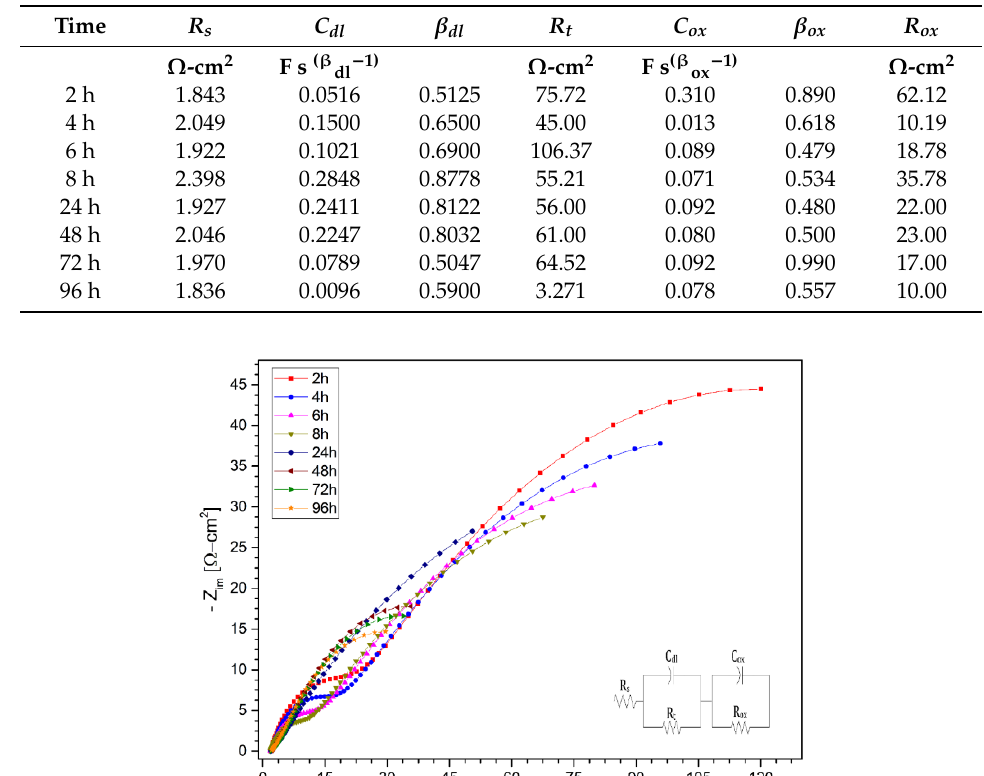
Figure 8. Nysquist diagram of stainless steel 430 layer in (KNa)NO 3 (solar salt) at 2 h, 4 h, 6 h, 8 h, 24 h, 48 h, 72 h and 96 h at 550 °C. Table 4. Fitting results of the impedance spectra of stainless steel 430 during corrosion in the presence of (KNa)NO 3 (solar salt) at 550 °C.